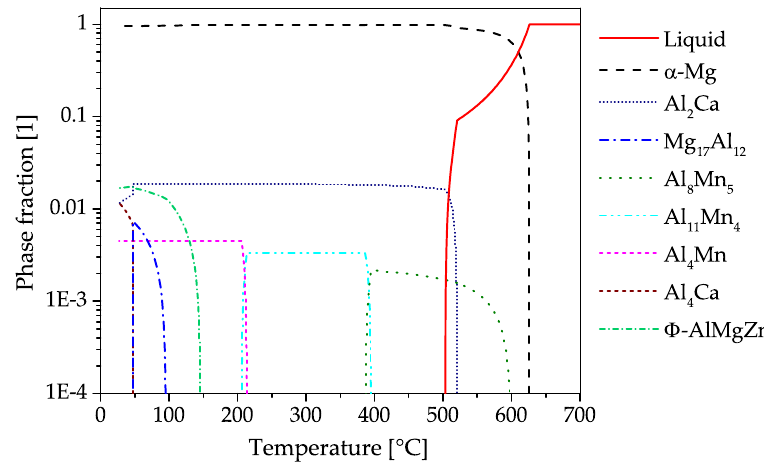
Figure 18. CALPHAD calculations (for further information see Appendix A) of AZX311 in a temperature range of 25 to 700 ◦ C, showing phase fractions of 10 − 4 to 1. The microstructure (cast, homogenized and as-forged) of an AZXW3110 alloy is shown